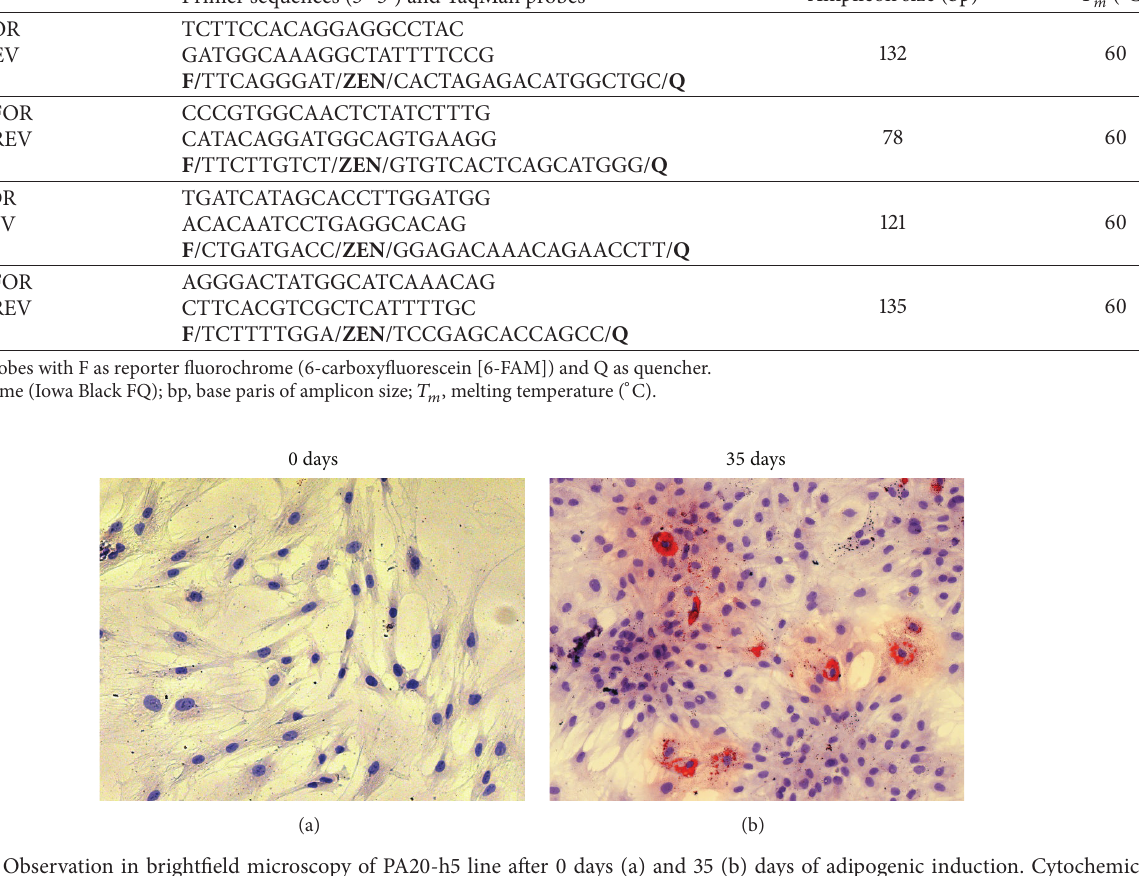
Figure 1: Observation in brightfield microscopy of PA20-h5 line after 0 days (a) and 35 (b) days of adipogenic induction. Cytochemical staining with Oil Red O; intracellular deposits of lipids stained in red; nuclei counterstained in blue-violet with hematoxylin (20x